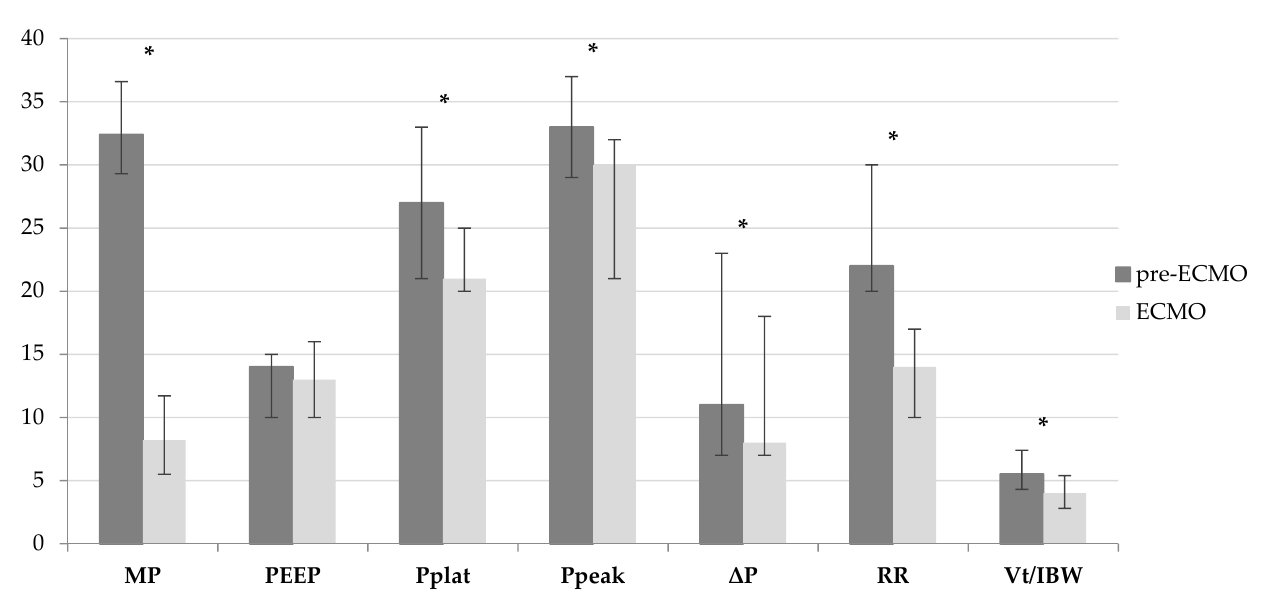
Figure 1. Differences in MV parameters before (pre-ECMO) and during the first 48 h after VV ECMO initiation (ECMO). [MV mechanical ventilation, VV ECMO veno-venous extracorporeal membrane oxygenation, MP mechanical power, PEEP positive end-expiratory pressure, P plat plateau pressure, P peak peak pressure, ∆ P driving pressure, RR respiratory rate, V T /IBW patient ideal body weight adjusted tidal